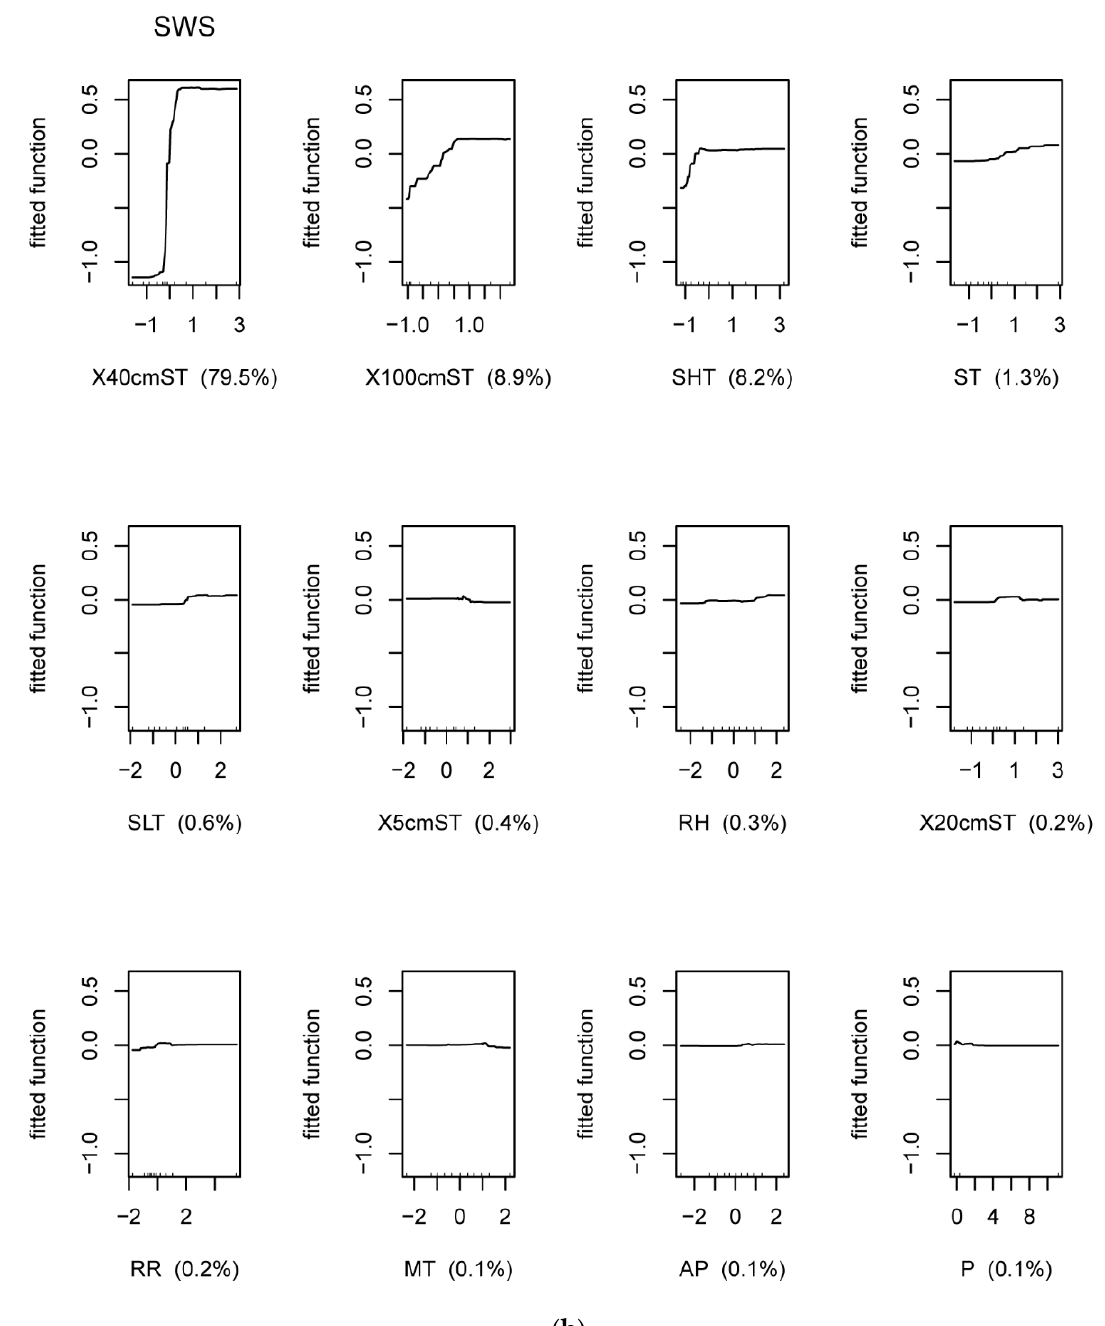
Figure 6. Partial effects of environmental factors on soil water storage during the frozen growing season ( a ) and non-growing season ( b ). The fitted functions from a BRT model were plotted using gbm. plot. The function gbm. plot. fit was used to plot the fitted values in relation to each of the predictors used in the model. Positive or negative relationships were indicated by the slope value; ×100 cm ST: 100 cm soil temperature, ×40 cm ST: 40 cm soil temperature, ×5 cm ST: 5 cm soil temperature, ×20 cm ST: 20 cm soil temperature, SLT: soil lowest temperature, ST: mean soil temperature, P: precipitation, MT: mean air temperature, SHT: soil highest temperature, RR: total reflected radiation, AP: air pressure, WS: wind speed, and RH: relative humidity.